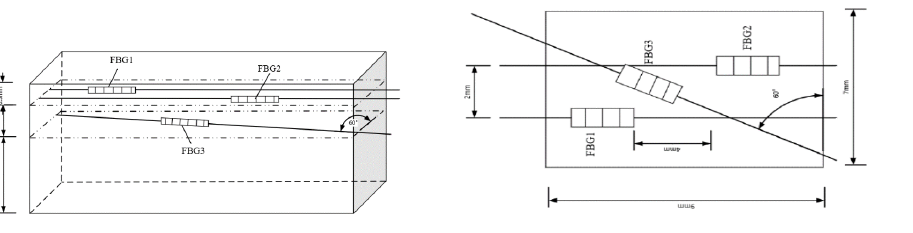
Figure 18. Sensor structure